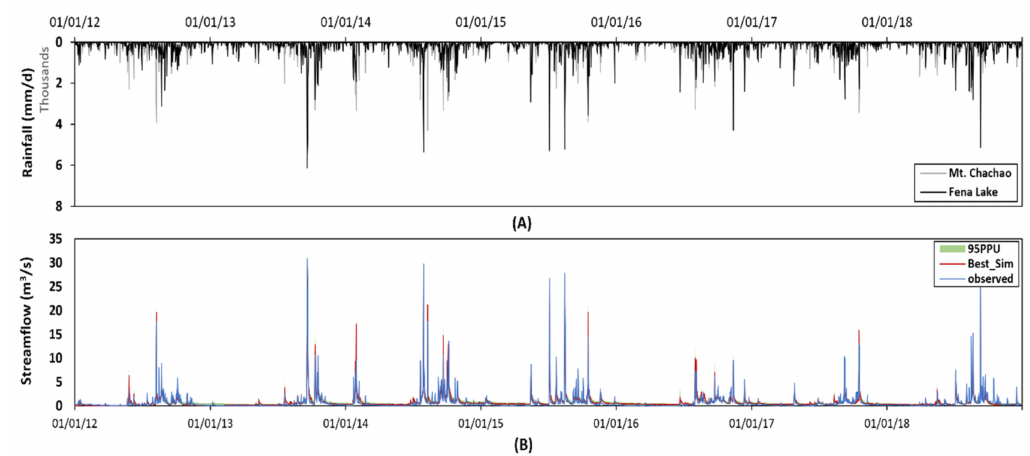
Figure 8. ( A ) Daily measured rainfall data sets from Mt. Chachao and Fena Lake rain gauge stations, and ( B ) observed, simulated daily streamflows, and the estimated 95% model uncertainty at USGS Pago River station (16,865,000) for the calibration period